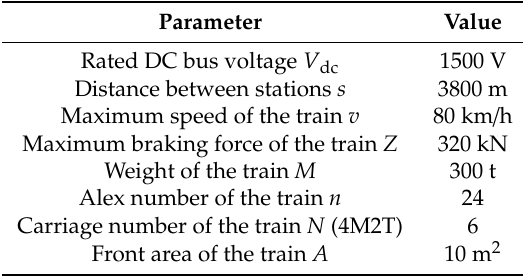
Table 1. Parameters of the traction calculation.